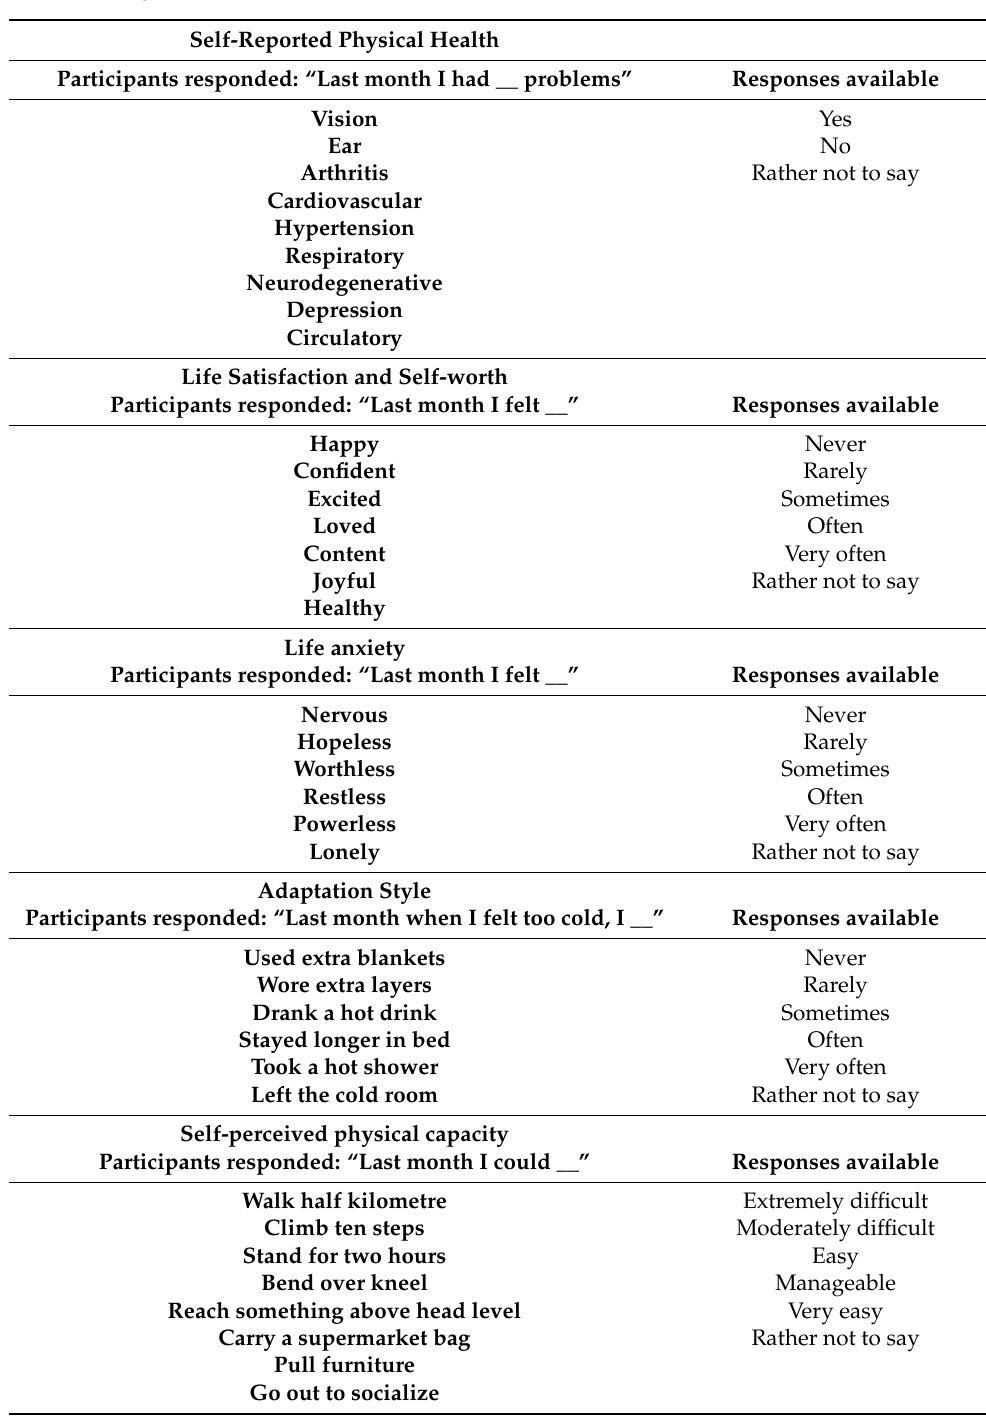
Table 4. Types of questions and answers included in the “long” surveys deployed during the fieldwork